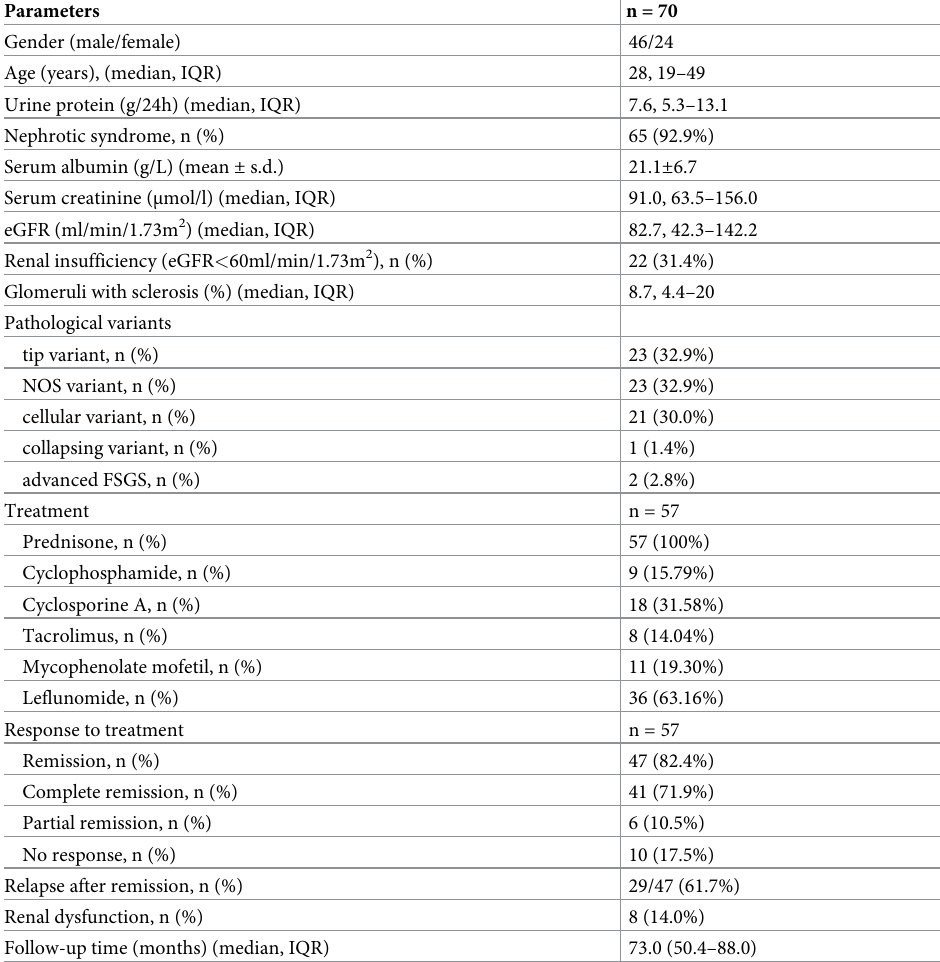
Table 1. The demographic and clinical parameters of patients with primary FSGS.